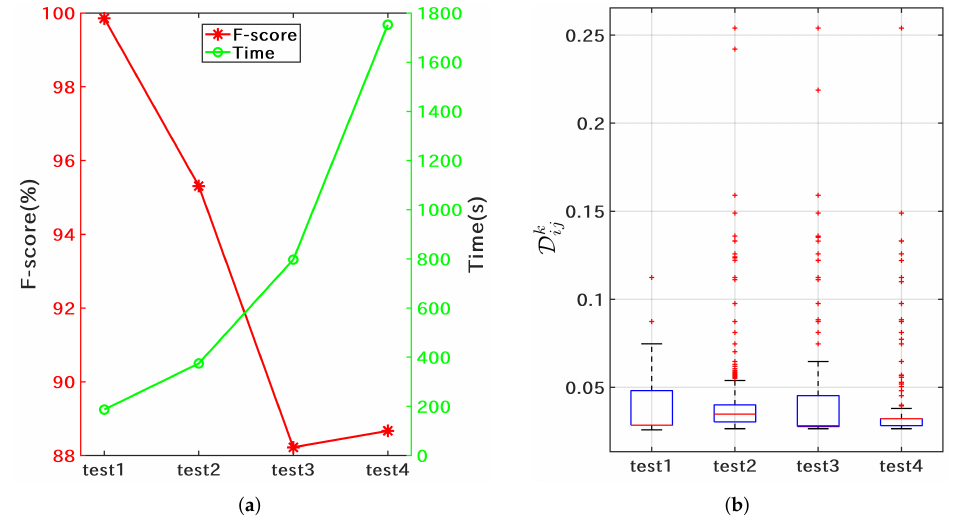
Figure 6. Template matching performance on the Nextstrain training set S N and the training time (green) for each of the tests; ( b ) difference statistics for misclassified samples.